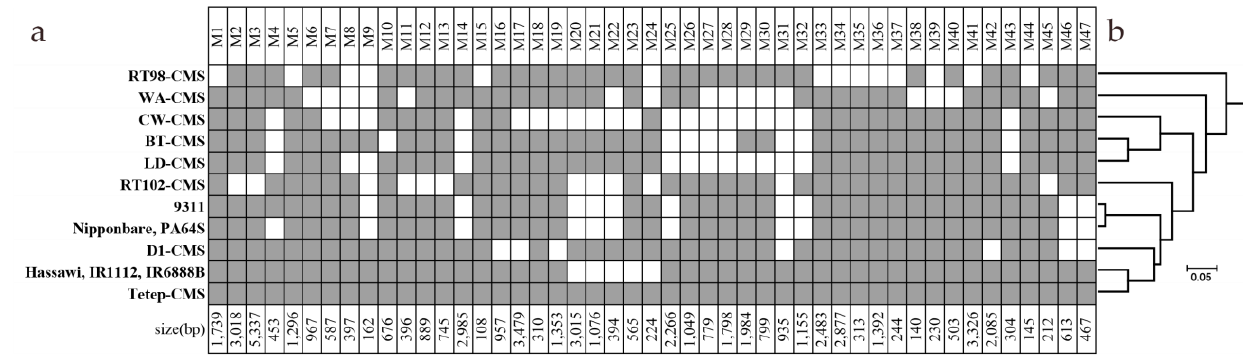
Figure 3. Distribution of MSSs specific to Tetep-CMS among the rice mitochondrial genomes. ( a ) Rice mitochondrial genomes with and without MSSs are represented by grey and white boxes, respectively. ( b ) UPGMA dendrogram based on 47 MSSs.